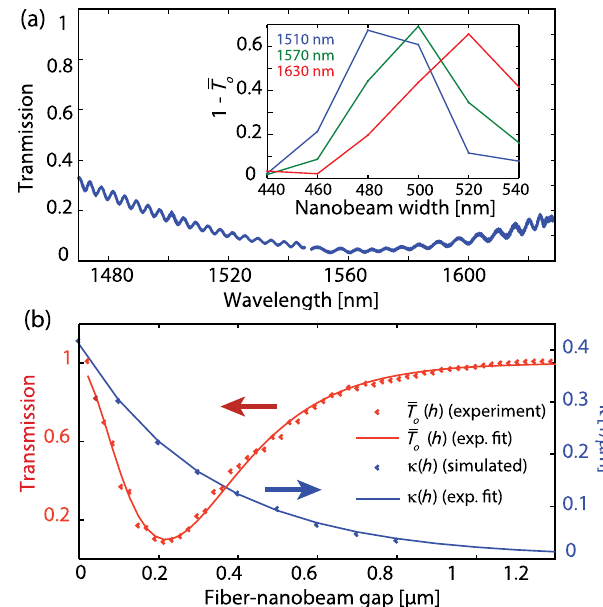
FIG. 3. Efficient evanescent waveguide coupling. (a) Fiber taper transmission T ð λ Þ versus wavelength for h ¼ 200 nm. Inset: Variation of T with nanobeam width w and λ for approximately constant h . (b) Dependence of fiber taper trans- mission on fiber height. Experimentally measured values for T (red points) are fit with the model described by Eq. (1) (red line). The corresponding κ ð h Þ extracted from the fit (blue line) and predicted from simulation (blue points) are also